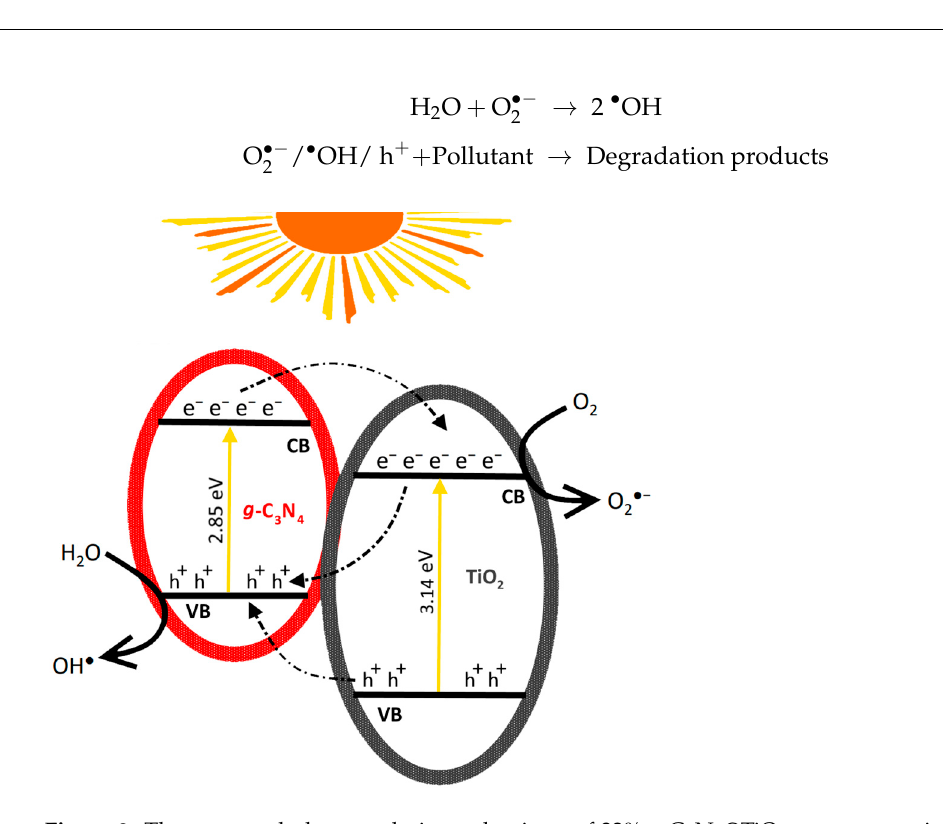
Figure 9. The proposed photocatalytic mechanisms of 32% g -C 3 N 4 @TiO 2 nanocomposite for MB degradation under simulated solar irradiation.